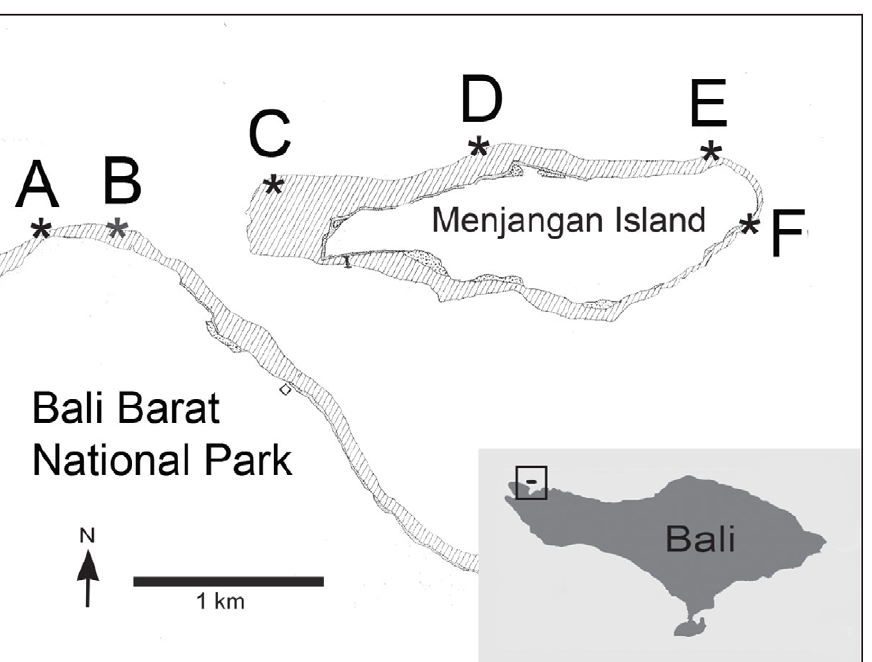
Figure 1. Digital Reef Rugosity study sites on the northwest corner of Bali, Indonesia. Study sites on mainland Bali at Kelor Point (A and B) and on Menjangan Island at Northwest Corner (C), Pasir Putih (D), Northeast Corner (E), and Pos 2 (F).